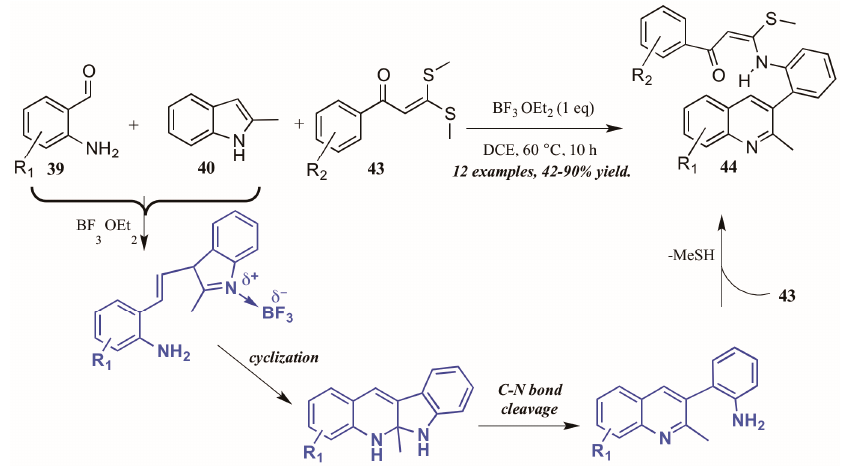
Figure 20. Lewis acid-catalyzed multicomponent Friedländer quinoline synthesis with dithioethers.